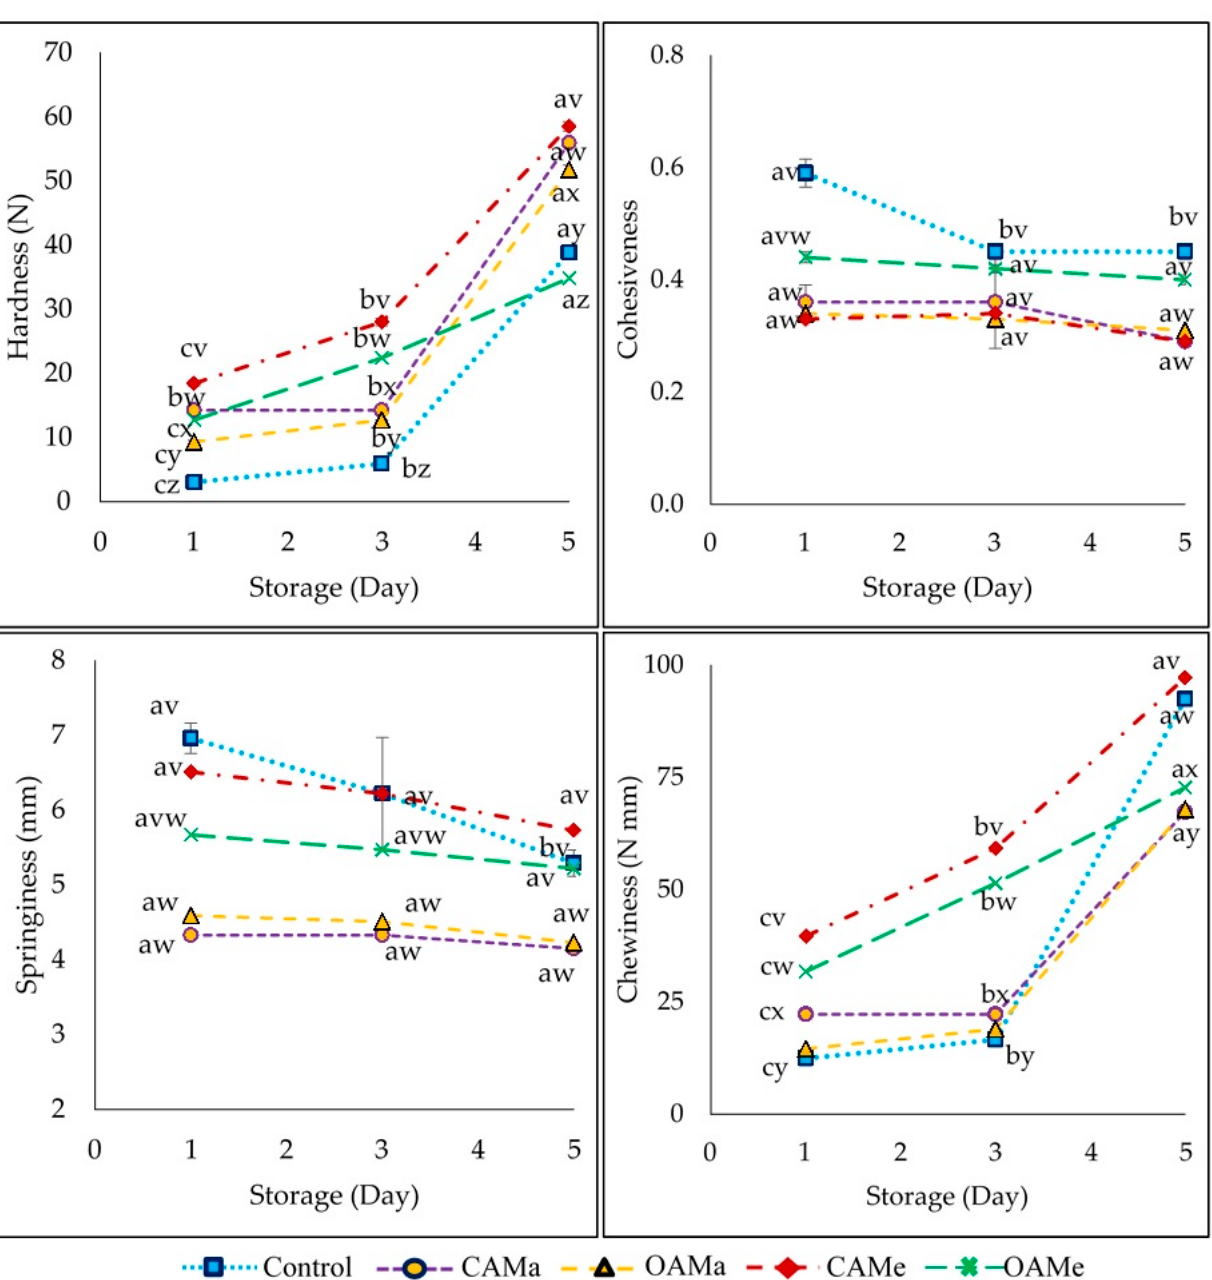
Figure 4. Textural properties of muffin. Results are the mean ± standard deviation. Two-way ANOVA: Different letters (a, b, c) show significant differences for each lot at different time ( p < 0.05). Different letters (w, x, y) show significant differences among samples at same time ( p < 0.05).